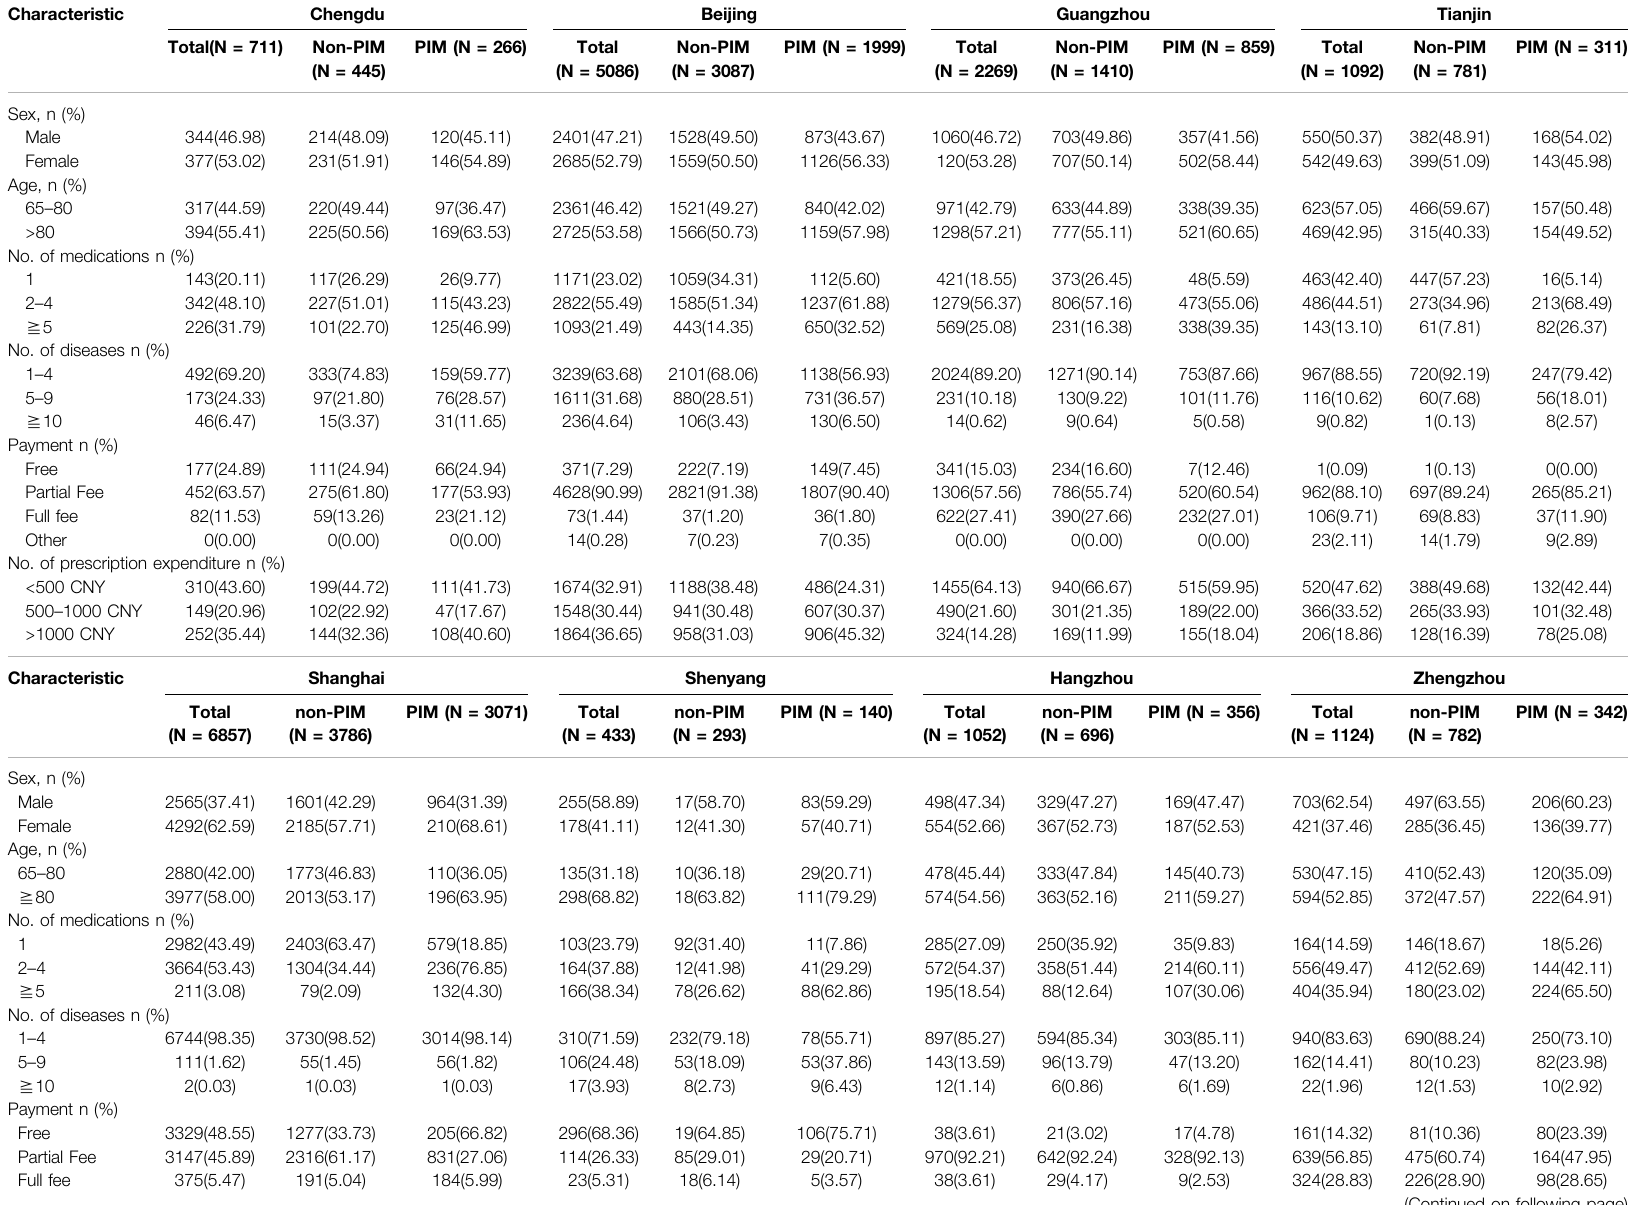
TABLE 1 | Basic characteristics of older outpatients with dementia in China.